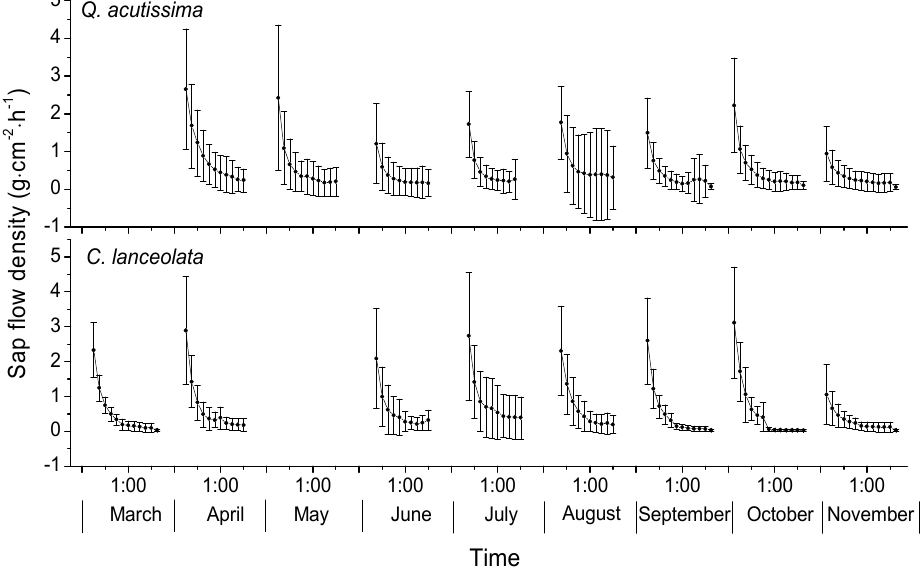
Figure 7. Daily variations of averaged nocturnal sap flow density in different months.